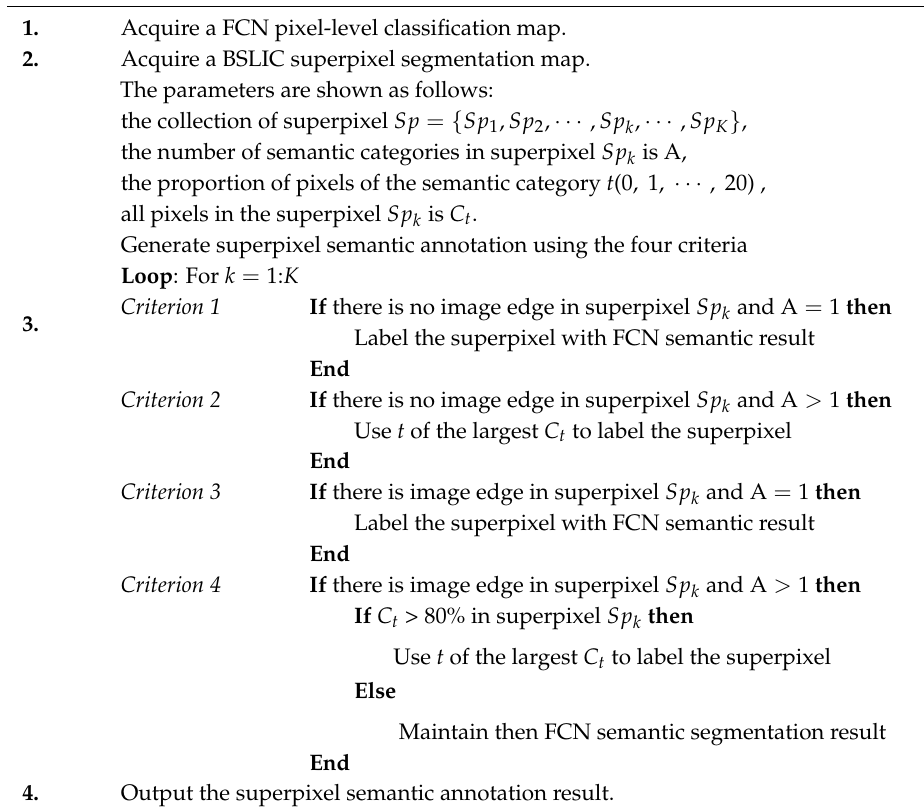
Algorithm 1. Superpixel semantic